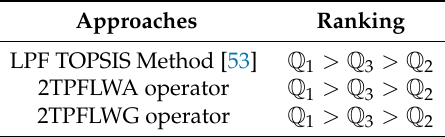
Table 6. Ordering of the